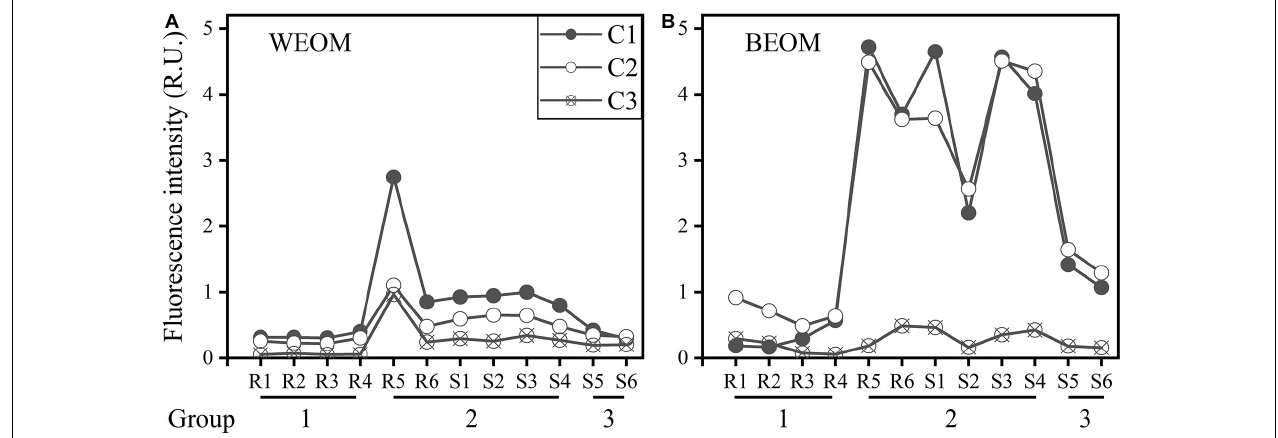
FIGURE 4 | Variability in fluorescence intensities of C1, C2, and C3 from the lower Yangtze River to the East China Sea in the water-extractable organic matter (WEOM) (A) and the base-extractable organic matter (BEOM) (B) .